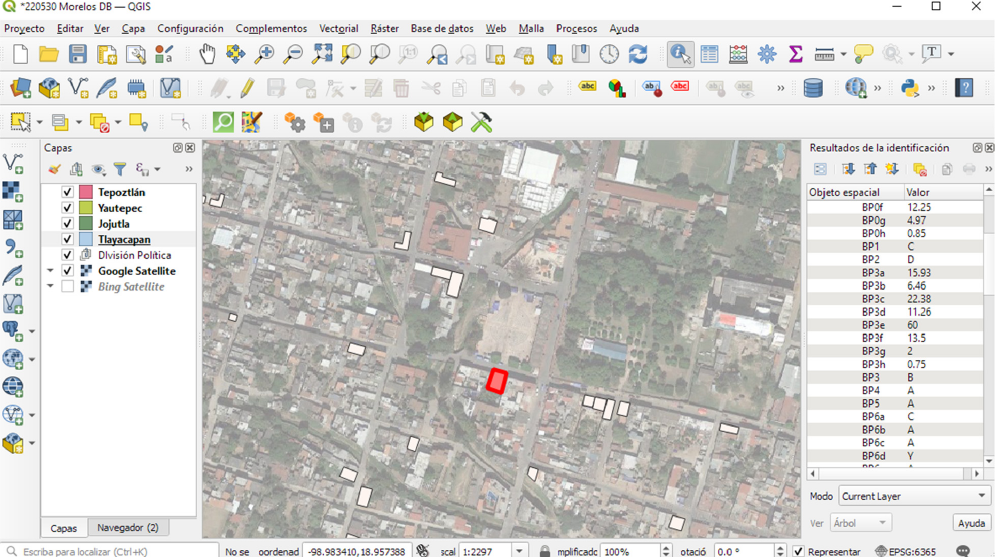
Figure 1. Screenshot of QGIS interface. The active layer includes a series of features associated with the parametric seismic vulnerability index for a specific set of constructions.